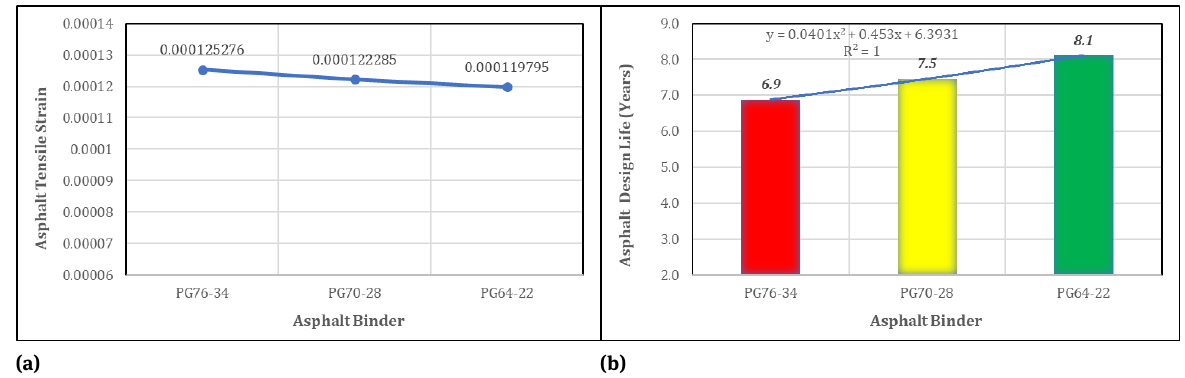
Figure 20: Effect of binder type on asphalt tensile strain (a) and on asphalt service life (b) in asphaltic overlayment rail track.